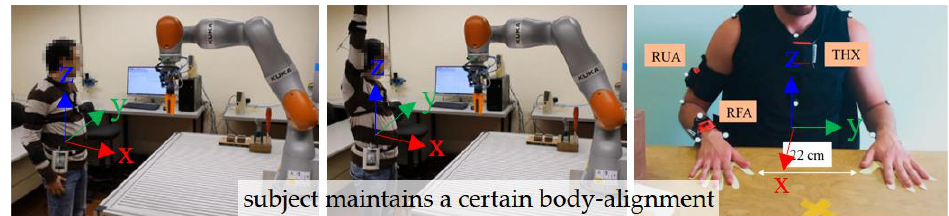
Figure 1. Wearable inertial-sensor-based remote manipulation; the subject maintains a certain body- alignment [12,13]. alignment [12,13].